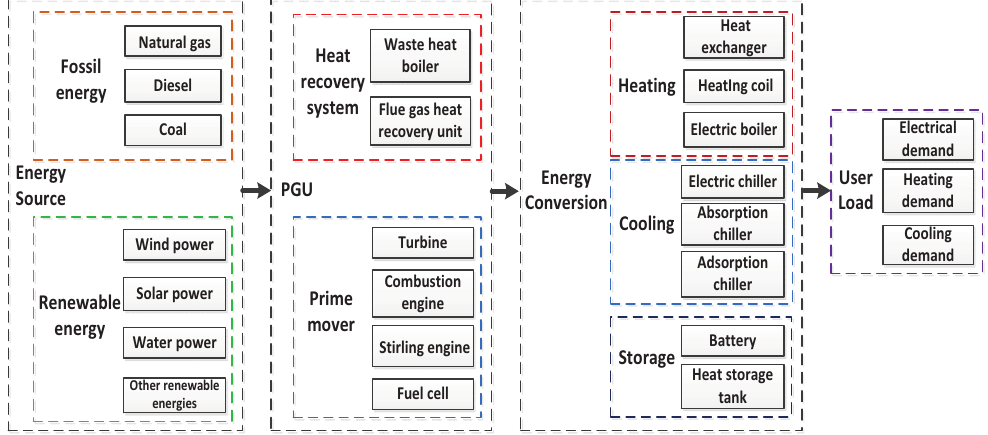
Figure 2. Illustration of the composition of a typical combined cooling, heating, and power (CCHP) system. PGU: power generation unit.